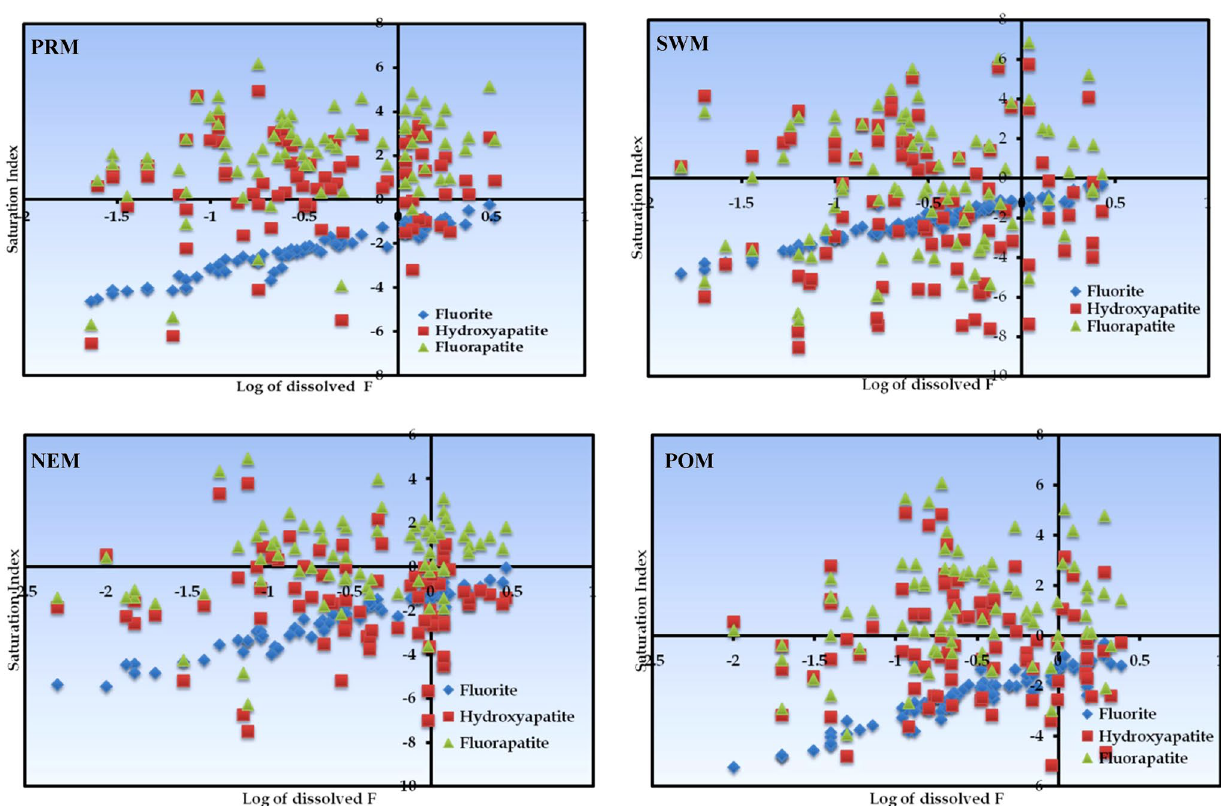
Fig. 5 Variation of saturation index of different fluoride minerals with dissolved F − for samples representing different